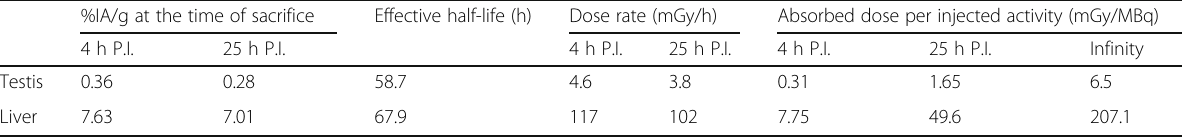
Table 1 Overview of the biokinetic data used as input for dosimetry calculations %IA/g at the time of sacrifice Effective half-life (h) Dose rate